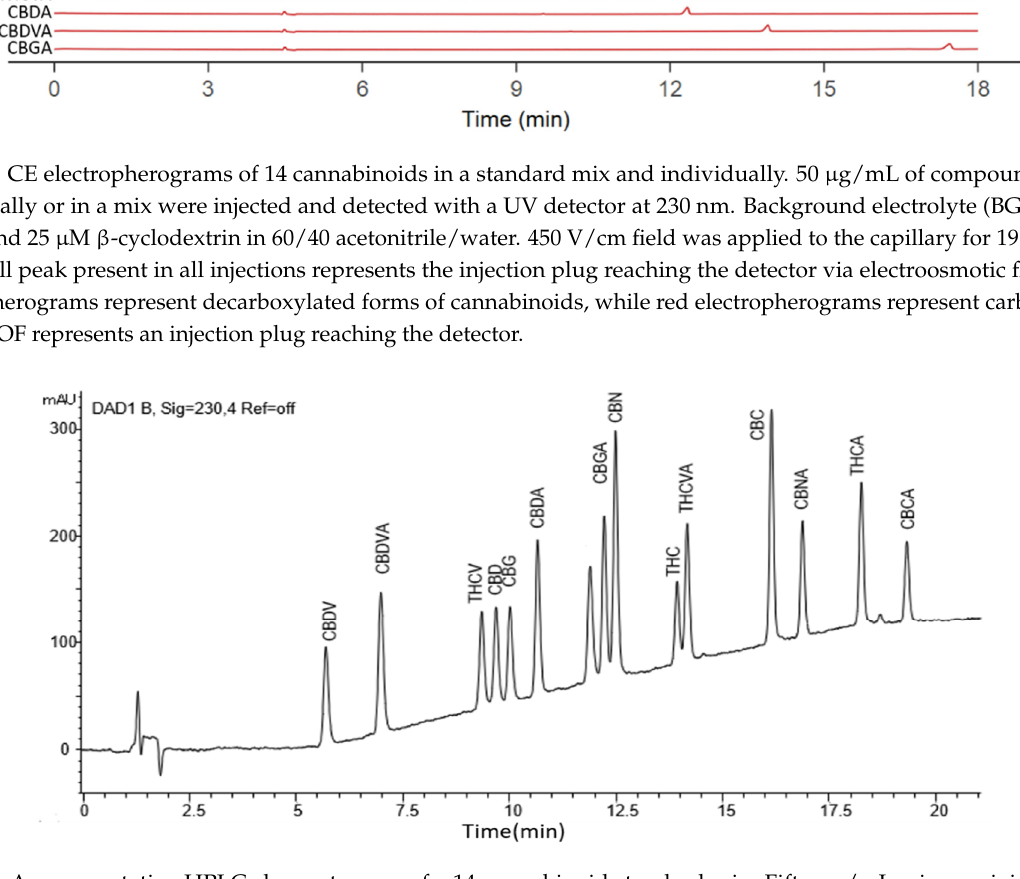
Figure 1. CE electropherograms of 14 cannabinoids in a standard mix and individually. 50 µg/mL of compounds either individually or in a mix were injected and detected with a UV detector at 230 nm. Background electrolyte (BGE): 6 mM NaOH and 25 µM β -cyclodextrin in 60/40 acetonitrile/water. 450 V/cm field was applied to the capillary for 19 min. The first small peak present in all injections represents the injection plug reaching the detector via electroosmotic flow. Blue electropherograms represent decarboxylated forms of cannabinoids, while red electropherograms represent carboxylated forms. EOF represents an injection plug reaching the detector.